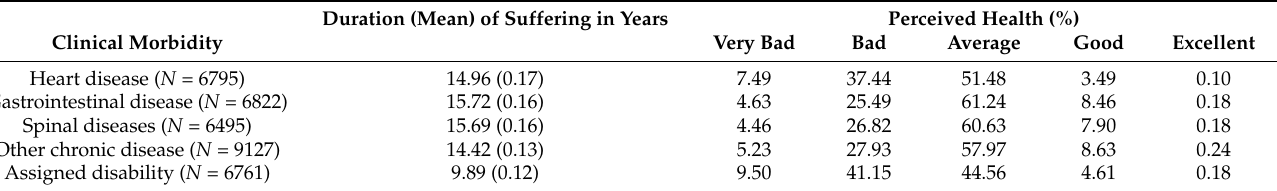
Table 1. Clinical morbidity and levels of perceived health status.